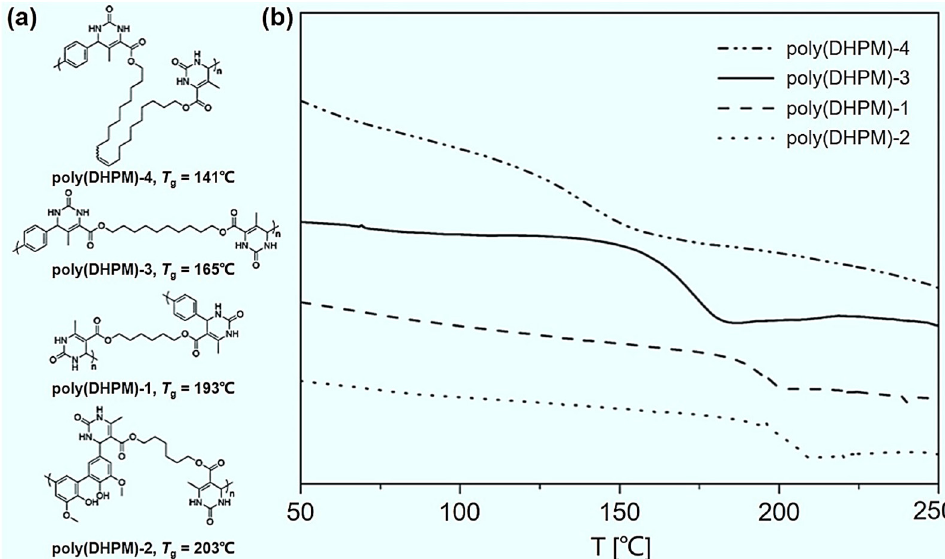
Figure 10. High-glass transition temperature ( T g ) renewable polymers produced via the Biginelli polycondensation. ( a ) The molecular structures of four different polymers (poly(DHPM)-1 to poly(DHPM)-4); ( b ) the corresponding differential scanning calorimetry analysis of poly(DHPM)-1 to poly(DHPM)-4. Reprinted with permission from ref. [22] . Copyright © 2016 WILEY-VCH Verlag GmbH & Co. KGaA, Weinheim. All rights reserved.